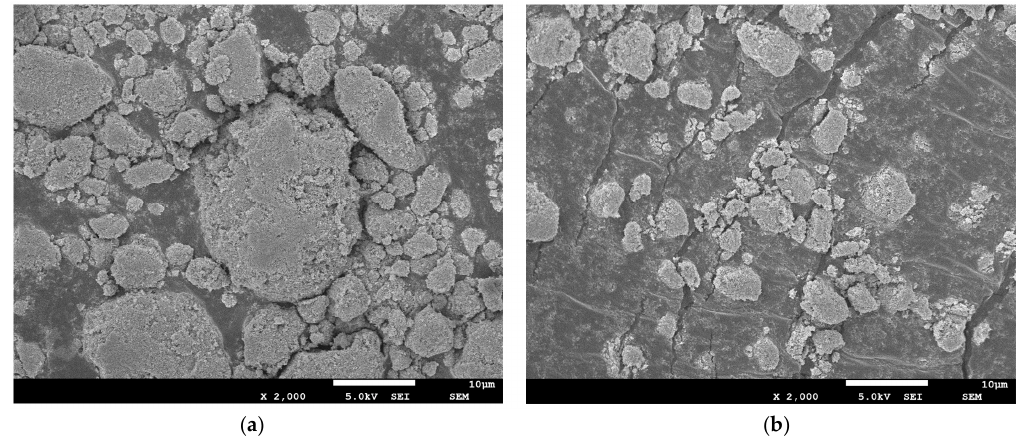
Figure 6. SEM images of ( a ) untreated TiO 2 and ( b ) A171-grafted TiO 2 nanoparticles.